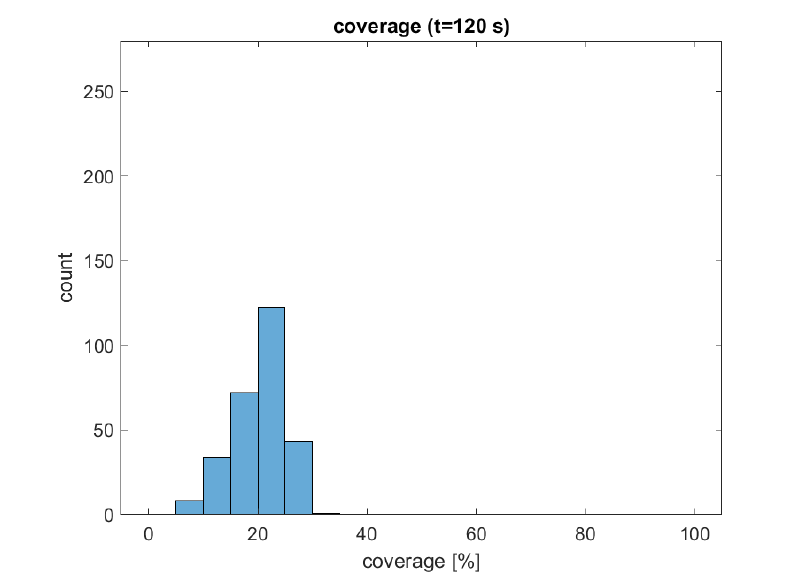
Figure 5. Distribution of coverage at 120 s of scenario